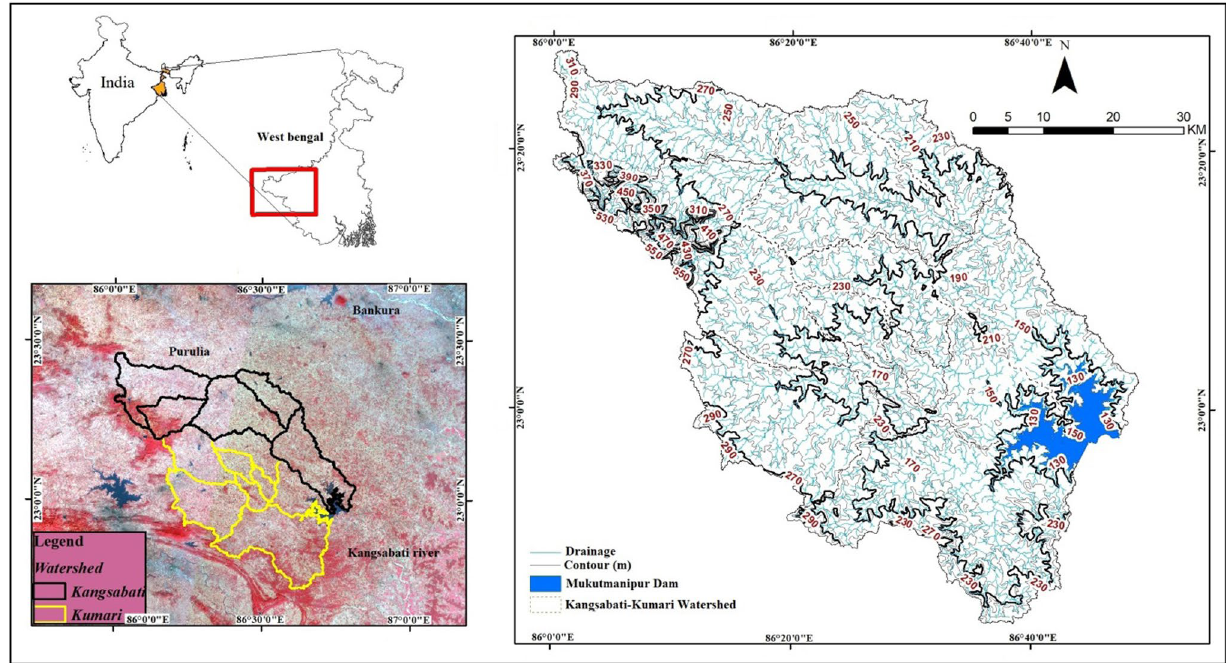
Fig. 1 Location map of Kansai–Kumari catchment